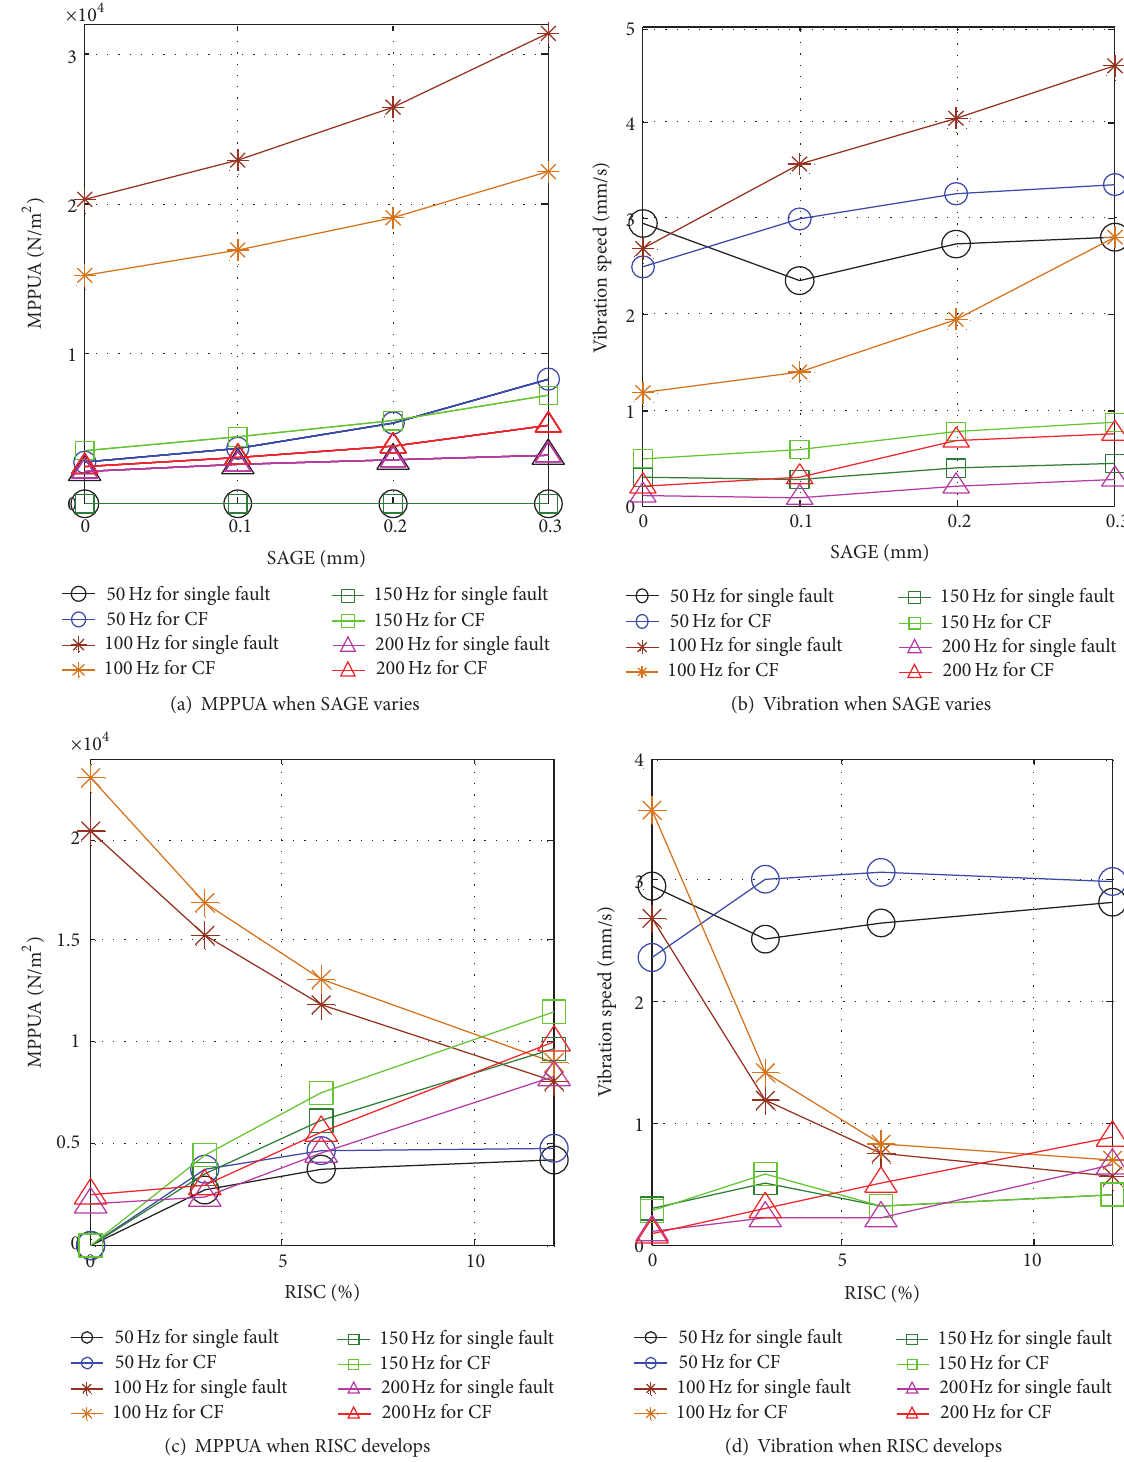
Figure 9: Comparison between MPPUA and tested stator vibration for different